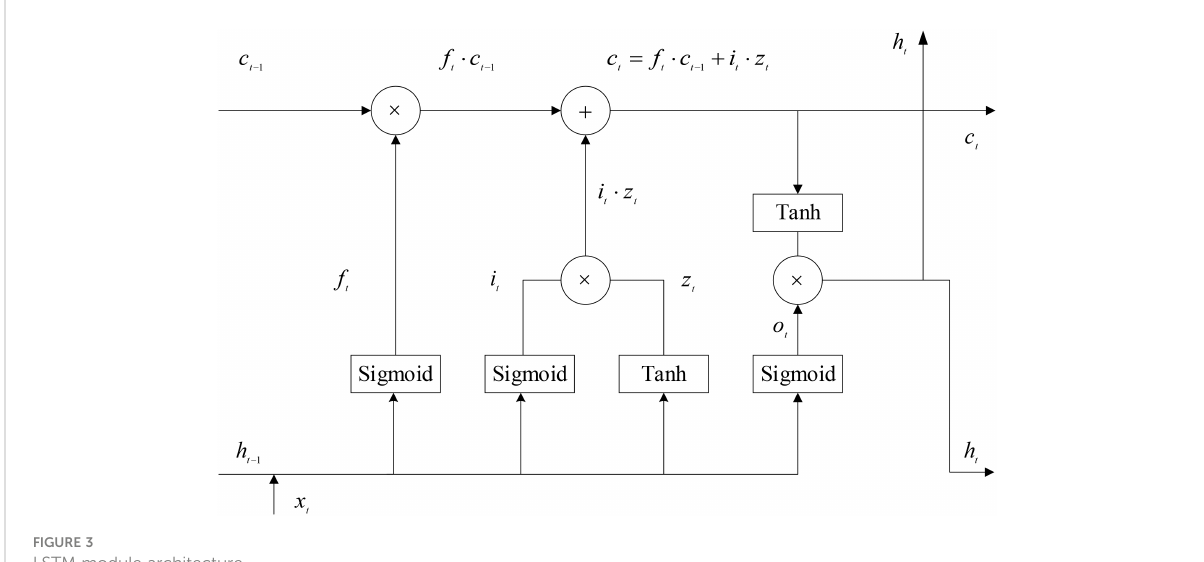
FIGURE 3 LSTM module architecture.